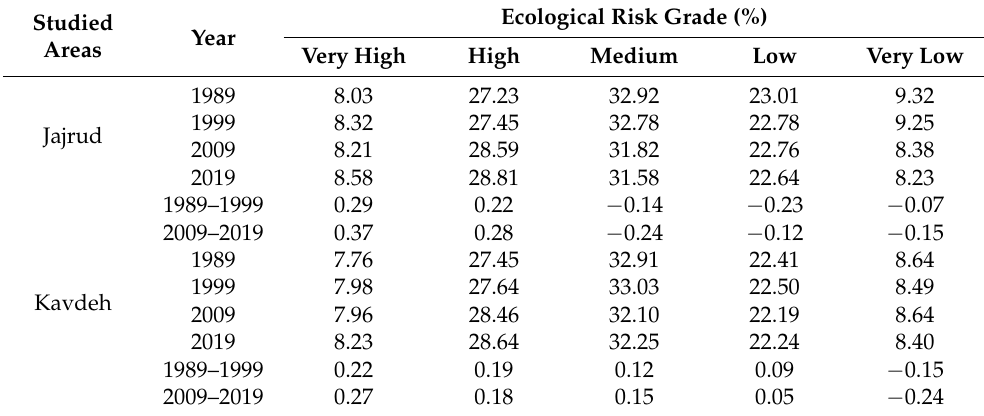
Table 7. Percent distribution of ecological risk in two Protected Areas in the Tehran province, Iran. Ecological Risk Grade (%) Studied Year Areas Very High High Medium Low Very Low